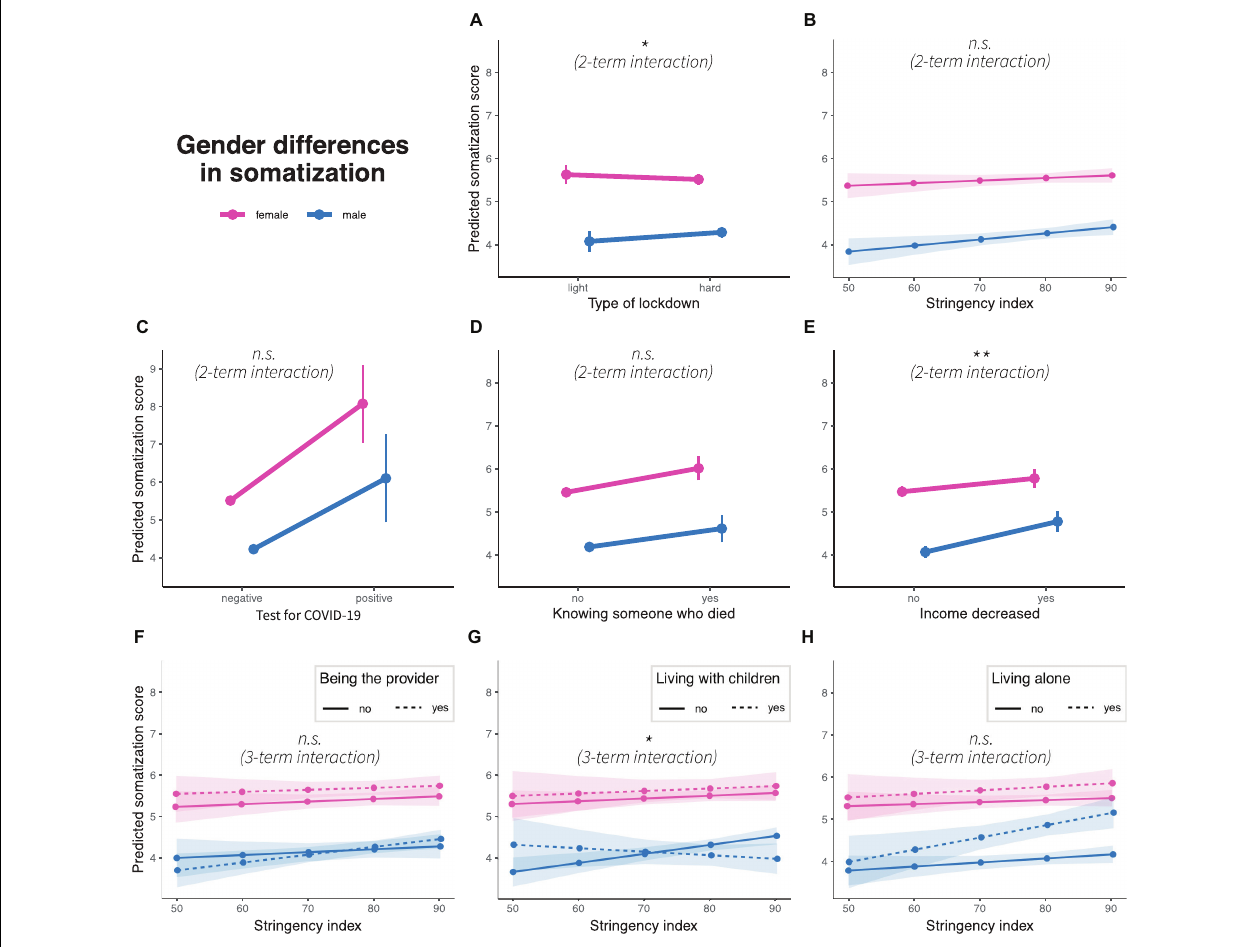
FIGURE 5 | Gender differences in predicted somatic symptom burden scores concerning (A) type of lockdown, (B) stringency index, (C) test for COVID-19, (D) knowing someone who died due to pandemic, (E) income decrease, and interaction of stringency index with (F) being the main household provider, (G) living with children and (H) living alone. Colors represent gender, dots represent marginal means, error bars or ribbons represent 95% confidence intervals. Linetypes represent at the bottom additional interaction terms. Significance of interaction effects are shown in italics; n.s.: non-significance. * p < 0.1 and ** p <